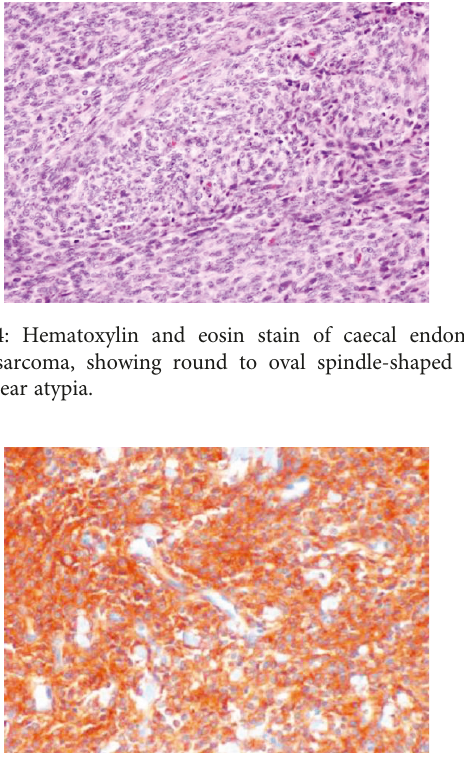
Figure 5: Immunohistochemistry picture showing CD10 positivity.